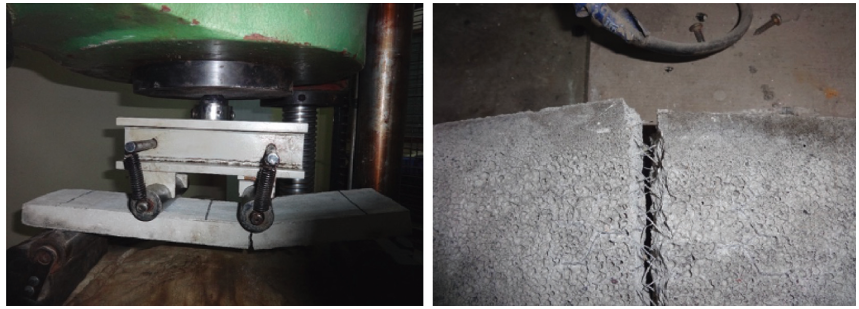
Figure 10: Polymer based flexural